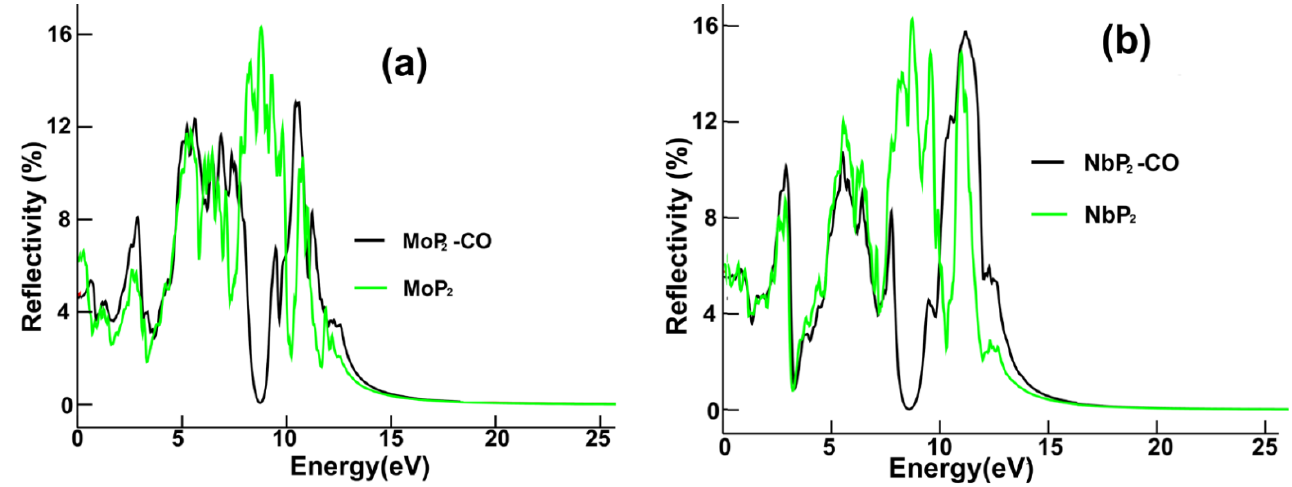
Figure 8. Reflectivity: ( a ) for pristine MoP 2 and MoP 2 -CO; ( b ) for pristine NbP 2 and NbP 2 -CO.